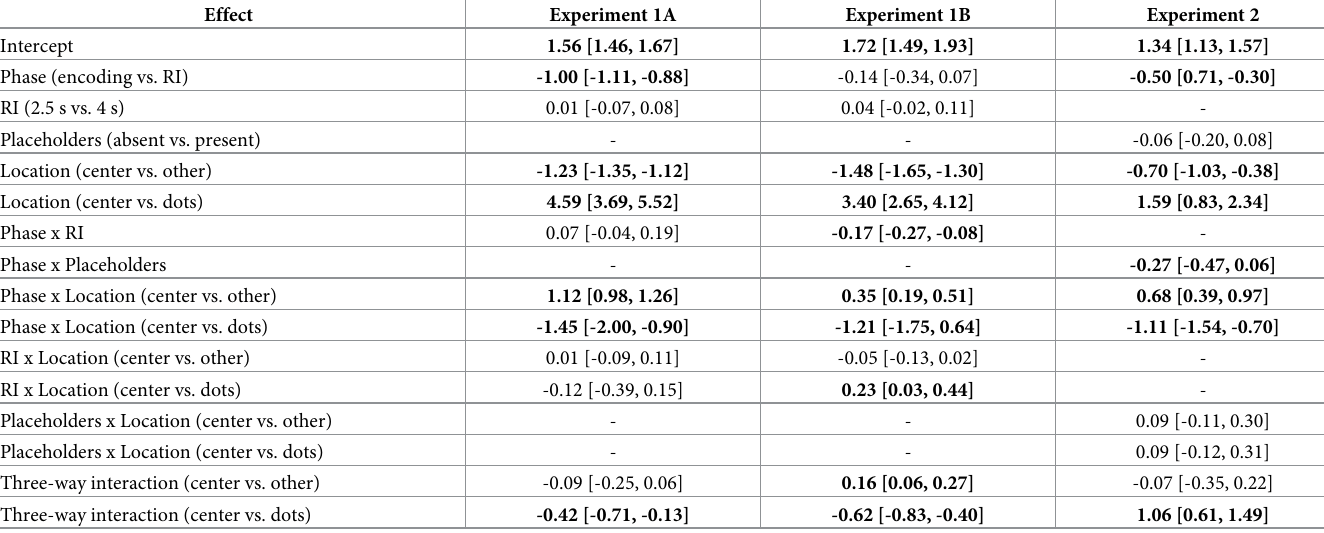
Table 1. Research question 1: Mean posterior estimates [and 95% credibility intervals, CIs] of the effects of the predictors on fixation rate in each experiment. The Condition Appearing First in the Parentheses was the Reference Variable.